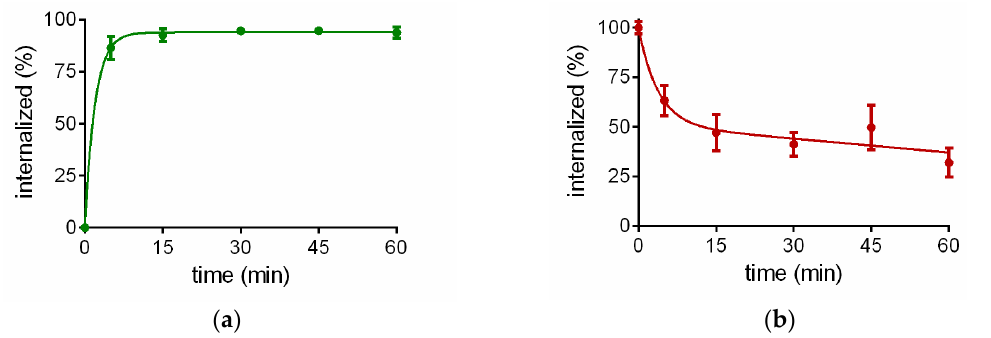
Figure 2. ( a ) Internalization rate of [ 68 Ga]Ga-TRAP(NT4) 3 in HT29 cells in vitro; ( b ) efflux of [ 68 Ga]Ga- TRAP(NT4) 3 from HT29 cells after internalization for 30 min. Each data point represents the mean ± standard deviation of three experiments performed in quadruplicate.